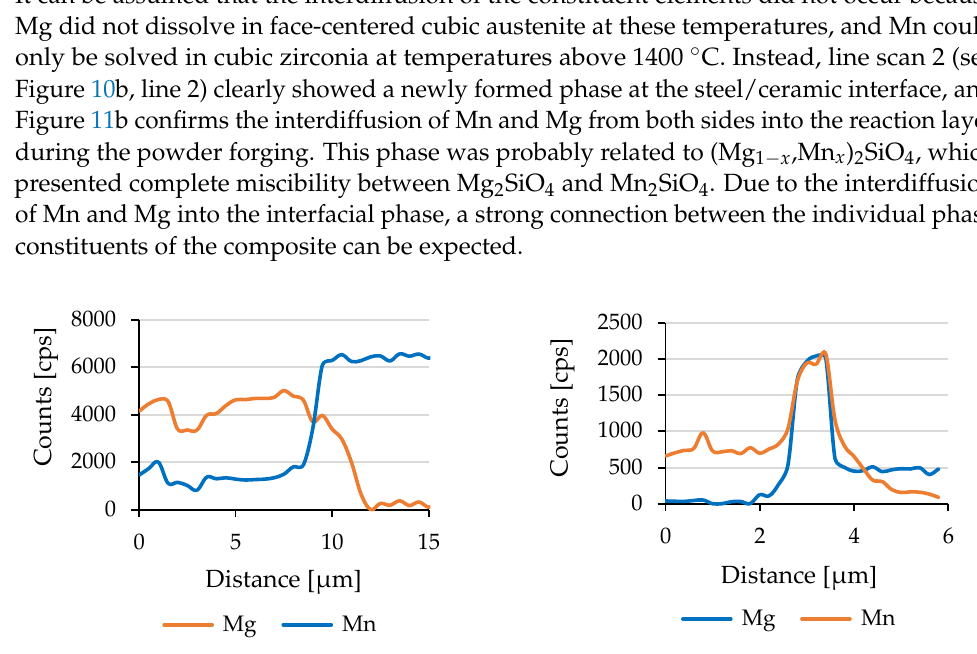
Figure 12. Tensile test specimens with ( a ) axially graded, ( b ) radially graded (1), ( c ) radially graded (2) particle distribu- tions, ( d ) light microscopy images of meridian sections of the axially graded specimen, ( e ) light microscopy images of meridian sections of the radially graded (1) specimen, and ( f ) light microscopy images of meridian sections of radially graded (2) specimen.